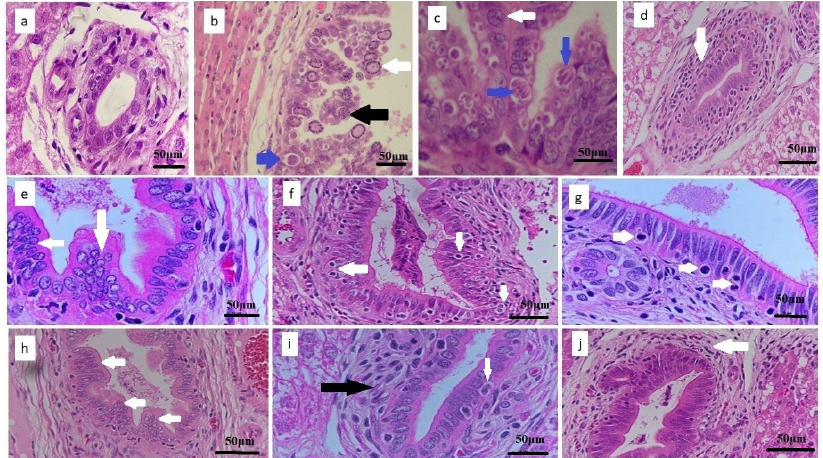
Figure 4. Hepatic histopathology: ( a ) normal hepatocyte, portal area, and bile duct tissue structures on day 28 PI (G1); ( b ) E. stiedae developmental stages [macrogametocytes (white arrow), microgametocytes (black arrow), and oocysts (blue arrow)] begin to form posterior to the nuclei of the epithelial cells in G2; ( c ) E. stiedae developmental stages [trophozoite (white arrow) and microgametes (blue arrows)] are displayed; ( d ) eosinophilia (white arrow) in the subepithelial cells and healthy epithelial lining (G3); ( e ) hyperplasia (white arrows) and no E. stiedae developmental stages are present (G3); ( f ) infiltration with an E. stiedae developmental stage (trophozoites) (white arrows) posterior to the nuclei of epithelial lining, desquamation of some epithelial cells, and eosinophilic infiltration in the subepithelial cells (G4); ( g ) few numbers of E. stiedae developmental stages (trophozoite) (white arrows) (G4); ( h ) hyperplasia (white arrows) and no E. stiedae developmental stages are present (G5); ( i ) few E. stiedae developmental stages (trophozoites) (white arrows) are present posterior to the nuclei, with eosinophilic infiltration (black arrow) in the subepithelial cells and healthy epithelial cells (G6); ( j ) few eosinophilic infiltrations in the subepithelial cells (white arrow) and epithelial cells appear healthy (G7).